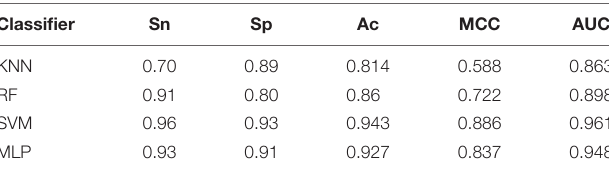
TABLE 4 | The comparison of different classifiers for discriminating phage hydrolases from other enzymes.